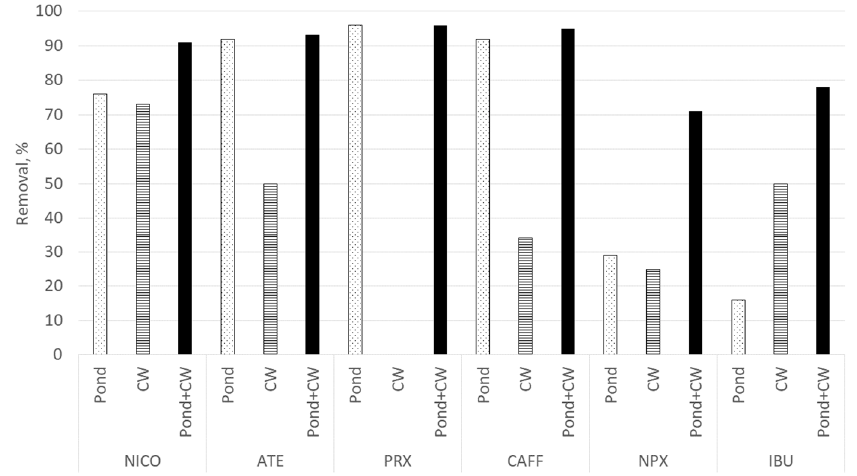
Figure 5. Removal (%) of PhCs in the pond, CW, and the complete system (Pond+CW) without Figure 5. recirculation.